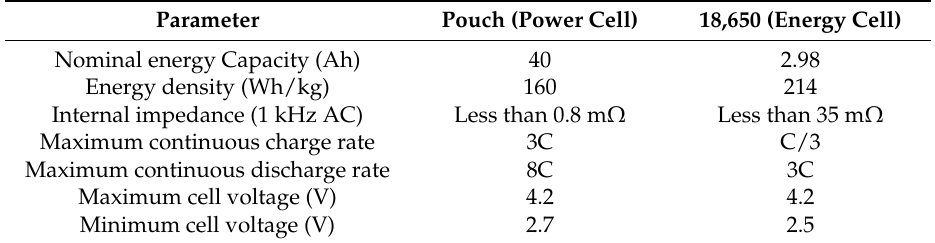
Table 1. Electrical performance data for both the pouch and 18,650 cell types from manufacturer